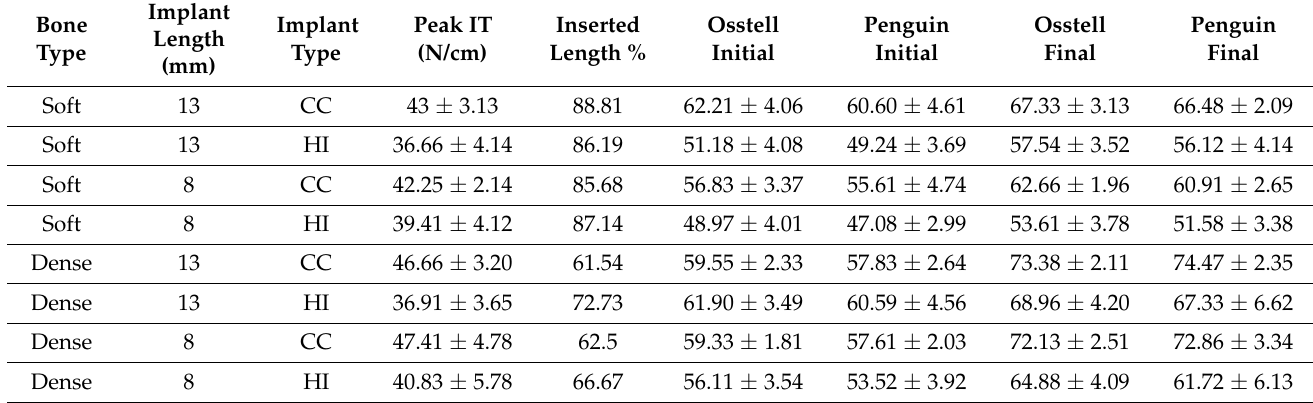
Table 3. The mean values and standard deviations of implant stability for the three measurements by each device for each group with similar parameters and percentages of inserted implant length: (N = 12, 11) IT = insertion torque, CC = conical implant, and IH =